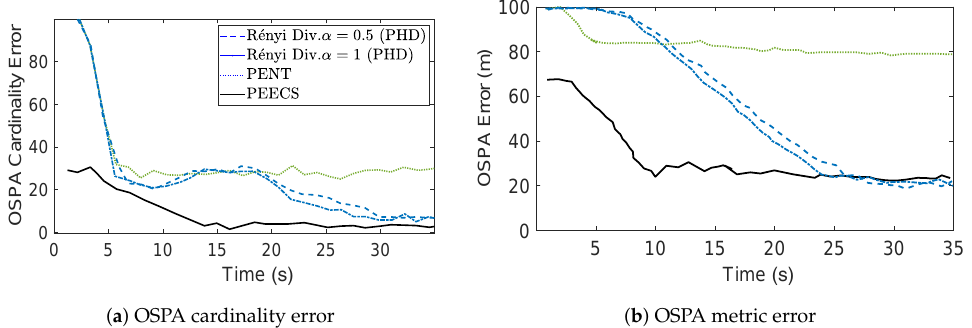
Figure 10. Estimation errors of the PEECS method compared to PHD-based sensor control methods (PENT [2] and Rényi divergence [12]) as reported in [26].